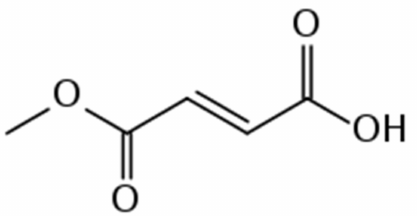
Figure 1. Organic structure of monnomethyl fumarate.